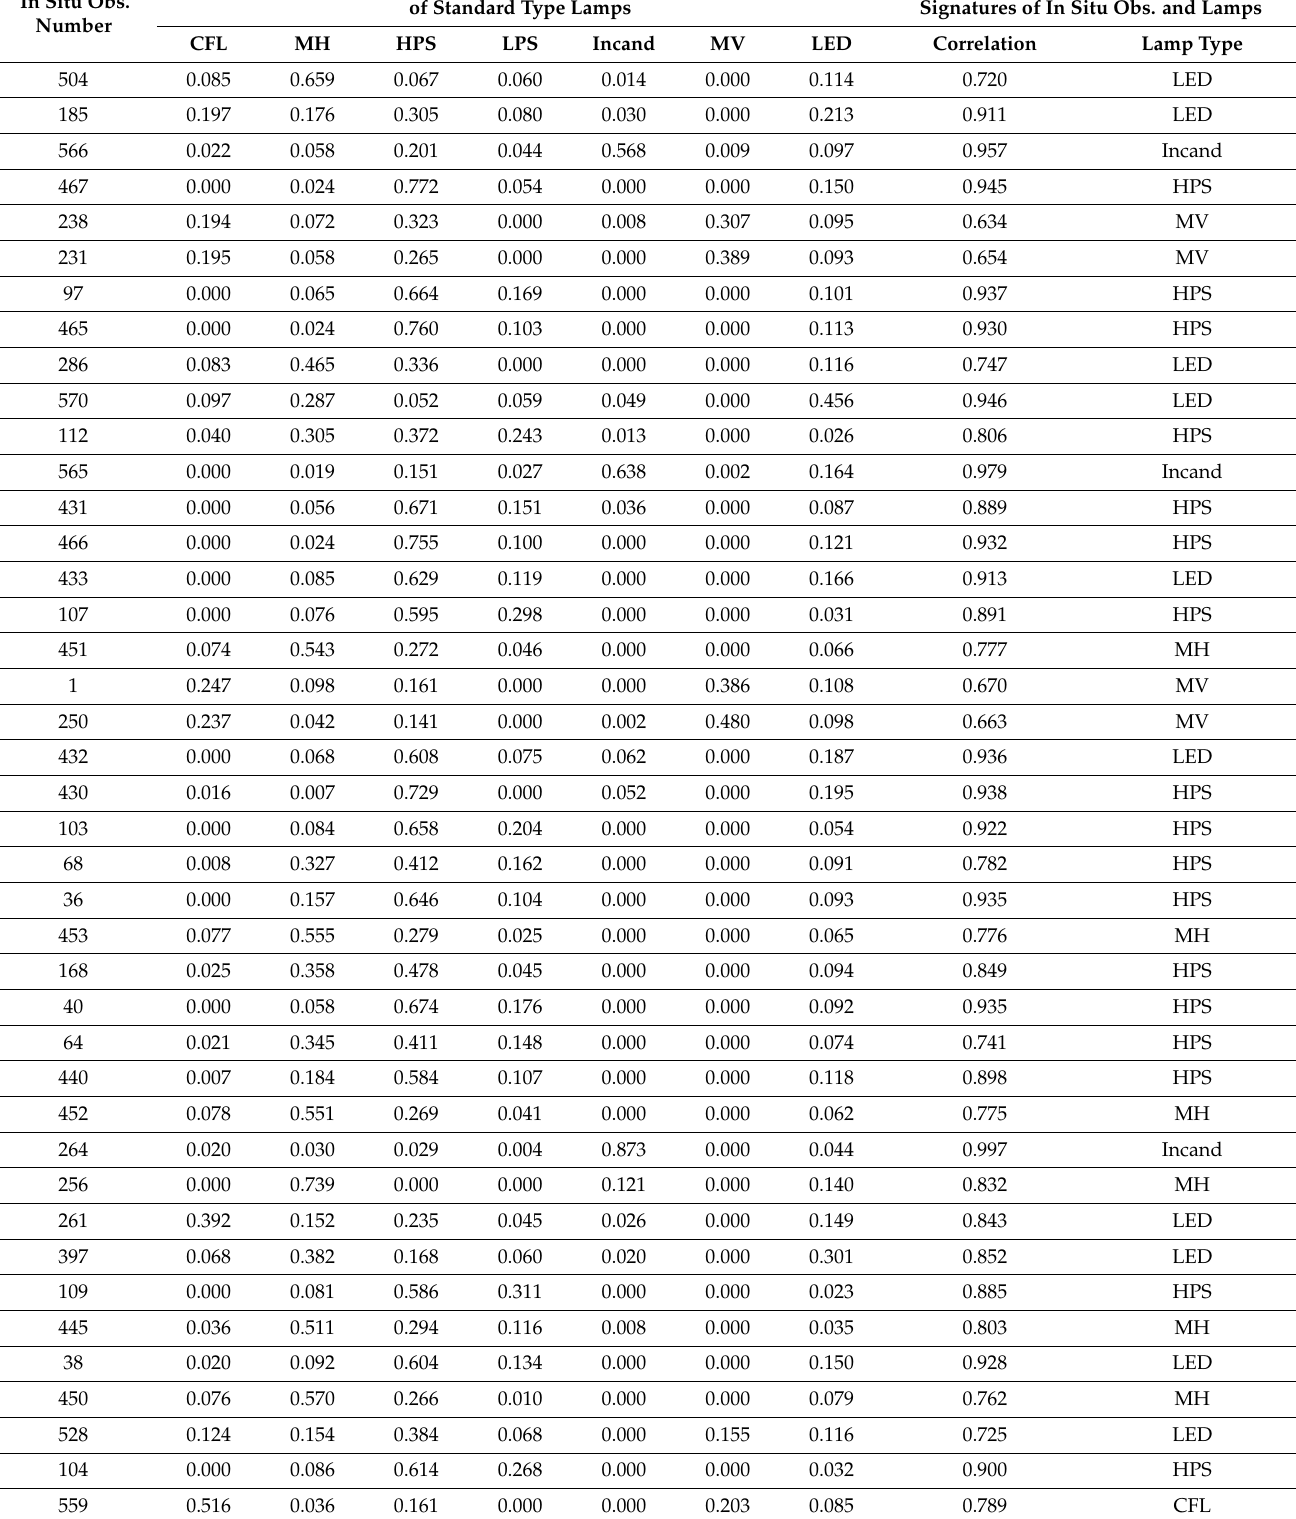
Table A1. Unmixing results: The relative contribution of each lamp type into the detailed spectral signature of in situ observation (see text for